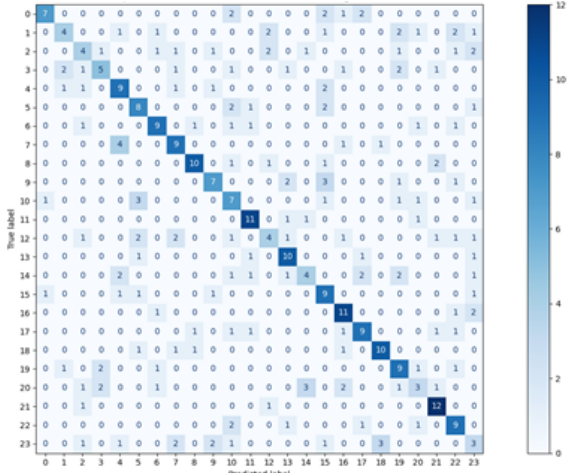
Figure 4. Confusion Matrix—Decison Tree.